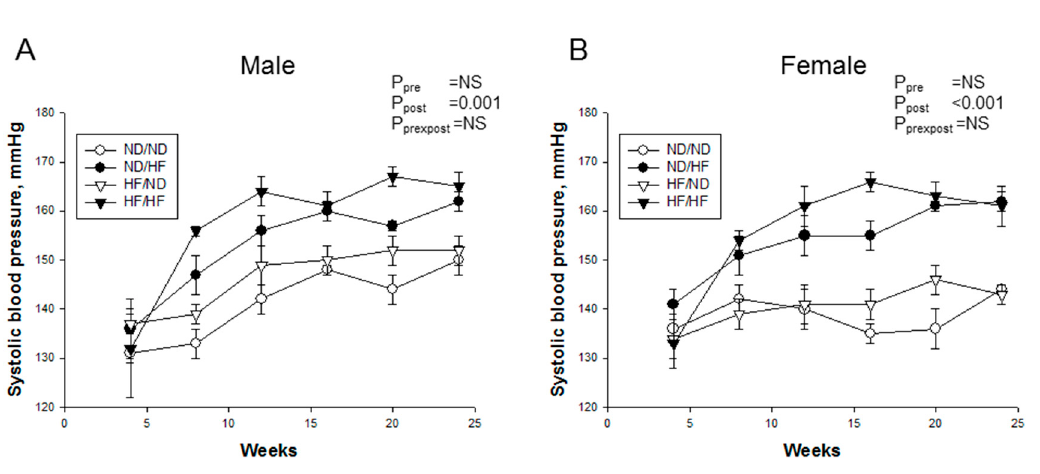
Table 2. Weights and metabolic parameters in offspring at six months of age.